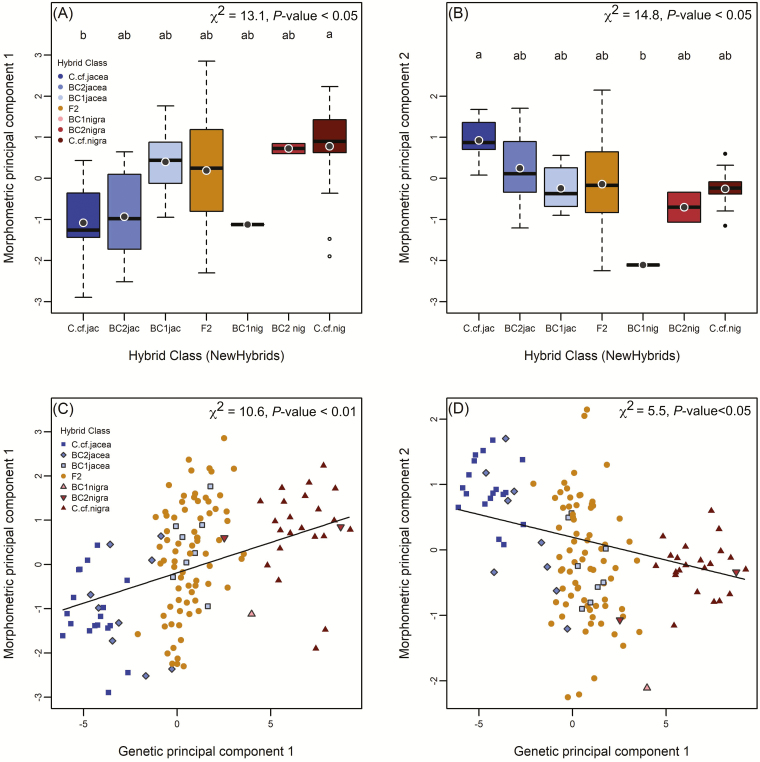
Associations between genetic ancestry and reproductive morphology. Mean individual scores for principal component 1 (A, C) and 2 (B, D) from the morphometric PCA (Fig. 4) predicted by NewHybrids hybrid class (A, B) or individual scores for genetic PC1 (C) and PC2 (D). Hybrid classes that do not share a lower-case letter differ significantly (P < 0.05) according to Tukey’s post hoc tests.